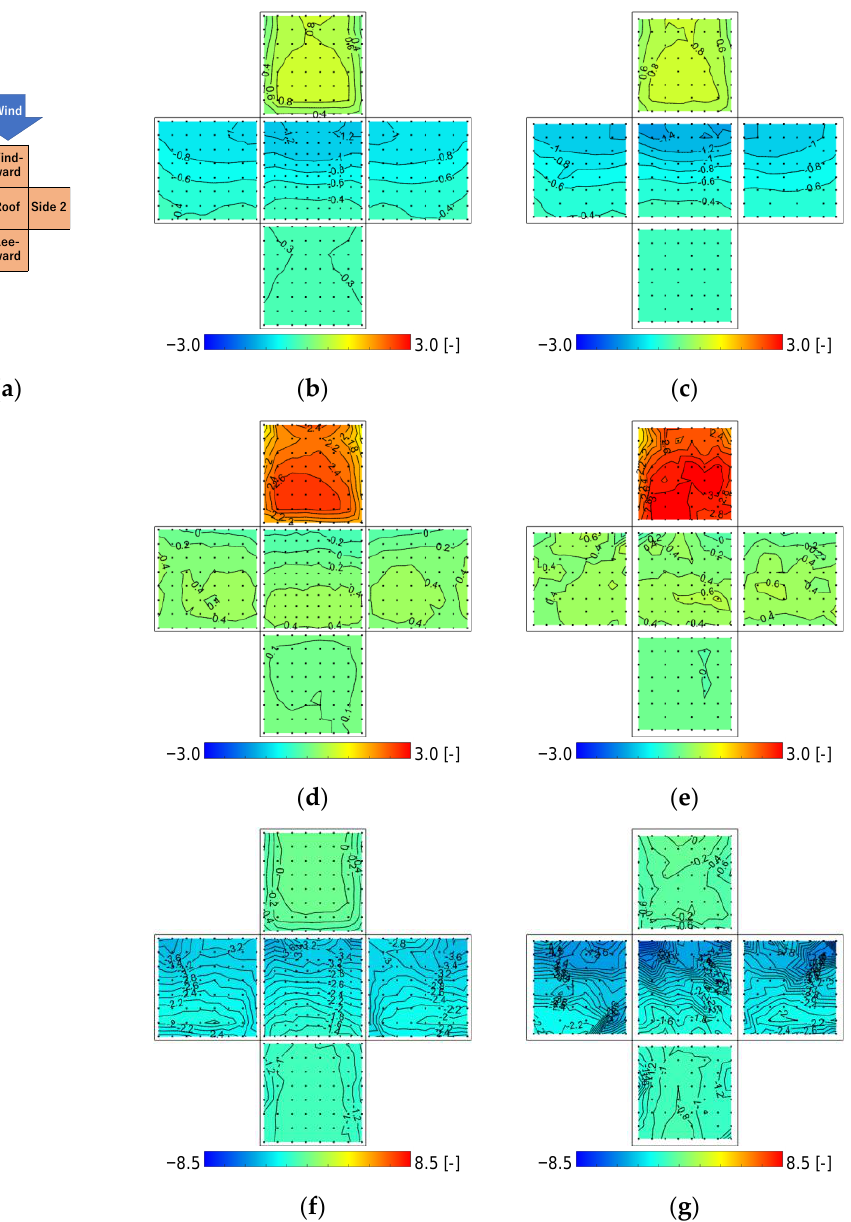
Figure 5. ( a ) Prevailing wind direction; ( b ) mean wind pressure coefficient 𝐶 𝑝 ̅̅̅ at wind direction of 0° in this study; ( c ) mean wind pressure coefficient 𝐶 𝑝 ̅̅̅ at wind direction of 0° in previous study [24]; ( d ) positive 𝑝𝑒𝑎𝑘𝐶 𝑝 at wind direction of 0° in this study; ( e ) positive 𝑝𝑒𝑎𝑘𝐶 𝑝 at wind direction of 0° in previous study [24]; ( f ) negative 𝑝𝑒𝑎𝑘𝐶 𝑝 at wind direction of 0° in this study; ( g ) negative 𝑝𝑒𝑎𝑘𝐶 𝑝 at wind direction of 0° in previous study [24].